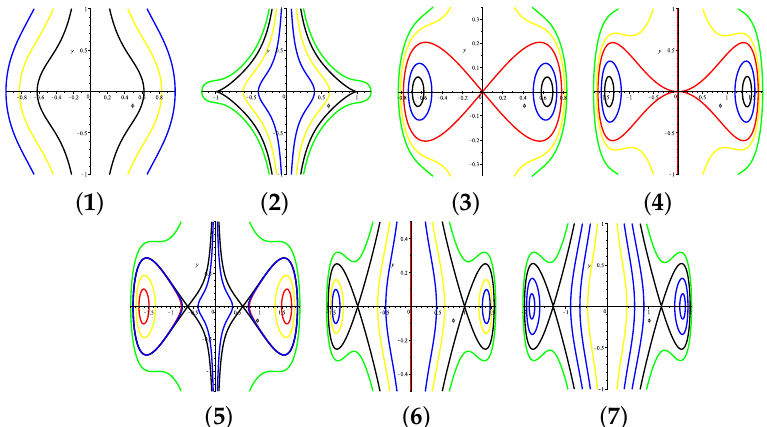
Figure 3. Phase portraits corresponding to system (5) under c > 0, ( 2 β − α )( a − 2 α ) > 0, a − 2 α > 0.